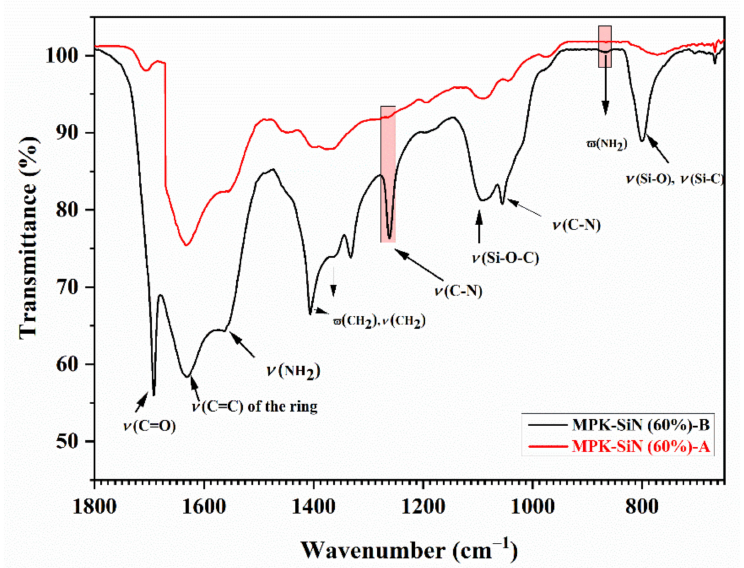
Figure 5. FTIR spectra of MPK–SiN (60%)-B (before) and MPK–Sin (60%)-A (after) immersion in KOH 1 M at 80 ◦ C for 216 h. ( ν : stretching and (cid:36) : wagging vibrations of